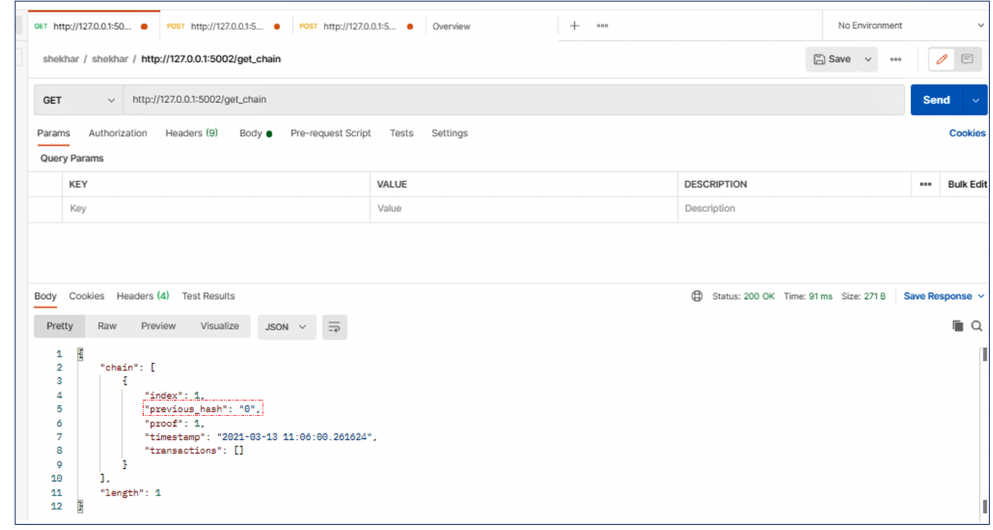
Figure A5. Obtain the current status of Blockchain.